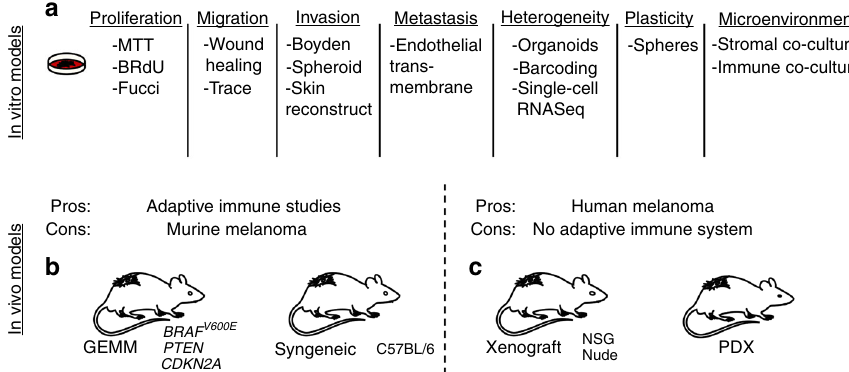
Fig. 2 Available melanoma models. a A large number of in vitro models are available to investigate speci fi c properties of melanoma cells, including proliferation, migration, invasion, metastasis, heterogeneity, plasticity, and microenvironment interactions. b In vivo models capable of investigating adaptive immune dynamics require murine melanoma models, whereas ( c ) models utilizing human melanoma tumor models lack functional adaptive human systems. Scienti fi c illustration toolkits from Motifolio (www.motifolio.com) were used to generate this fi